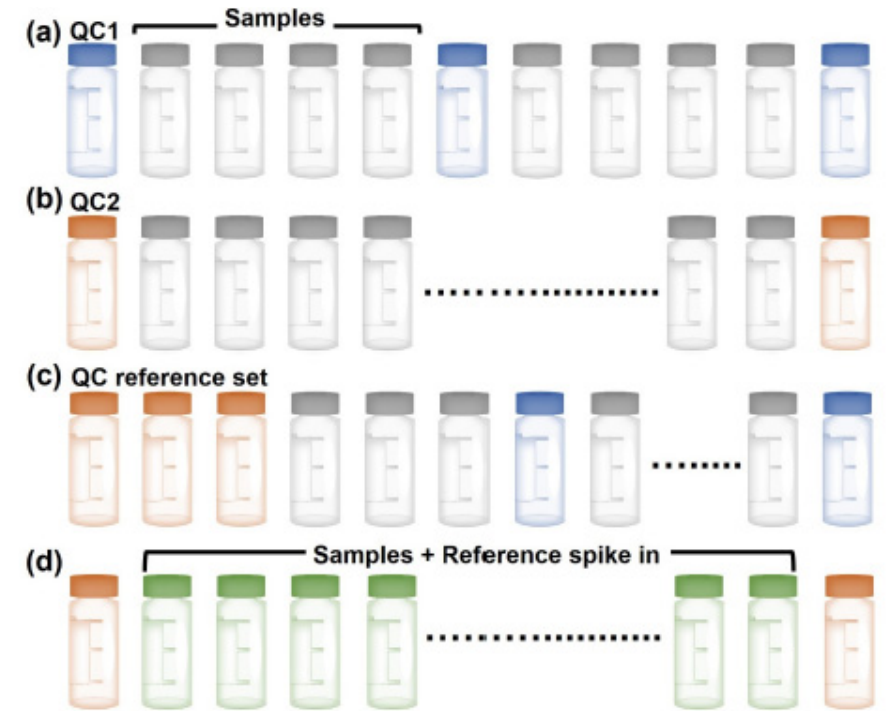
Figure 9. Standard experimental designs integrating quality control (QC) samples to evaluate the LC-MS / MS instrumentation for targeted or large-scale proteomic measurements. Simple QC samples including single peptide, peptide mix, or single protein digest (QC1) are in blue. More complex QCs comprising whole proteome digests (QC2) are in orange. Sample integrating a reference spike in are in green. The grey vials indicate the samples to be measured.